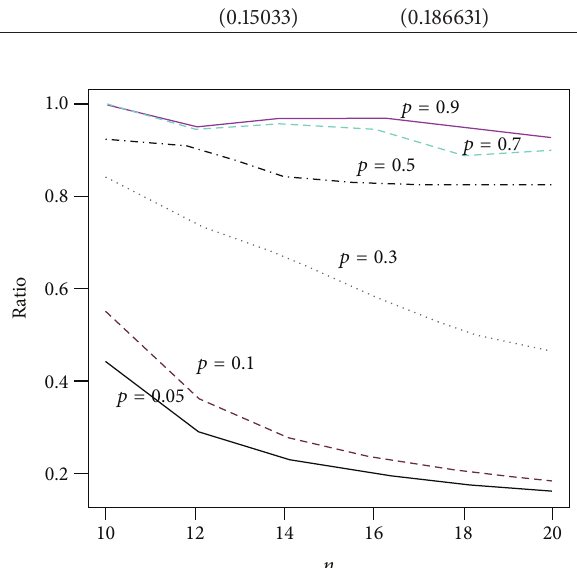
Figure 1: 𝛿 under PT-II CBR to 𝛿 REET